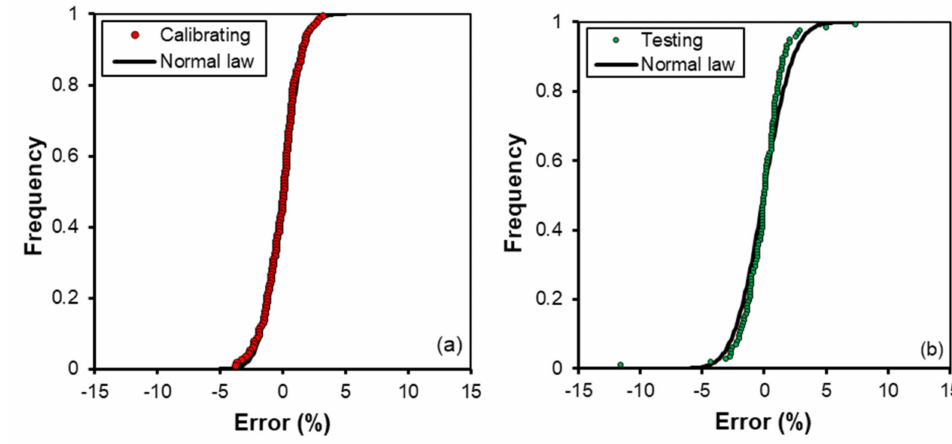
Figure 8. Frequency distribution of the errors in discharge estimate Er applying Equations (23) and (24) for calibrating ( a ) and testing ( b ) datasets.